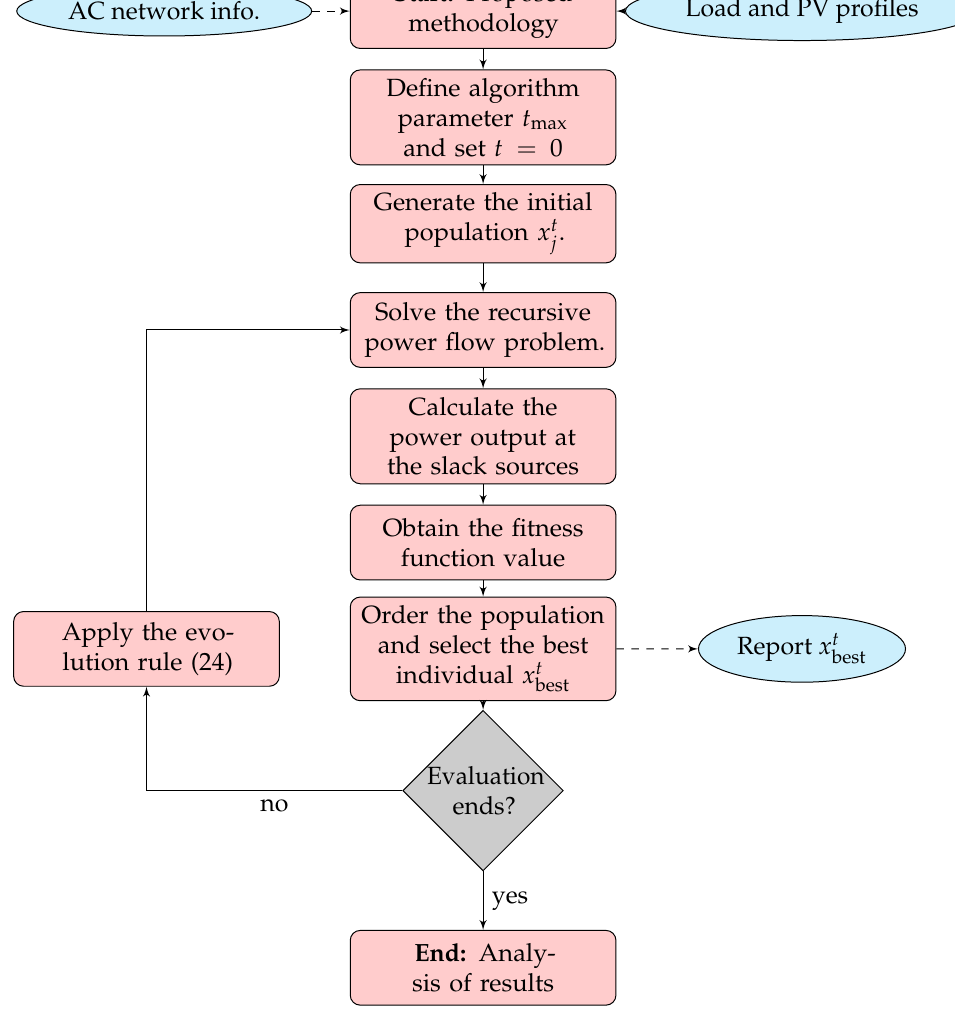
Figure 1. Implementation guide for the proposed optimization